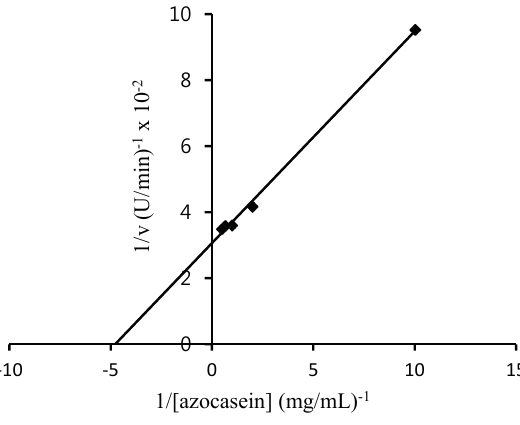
Figure 5. Lineweaver-Burk plot for the effect of substrate concentration on activity of the ginger